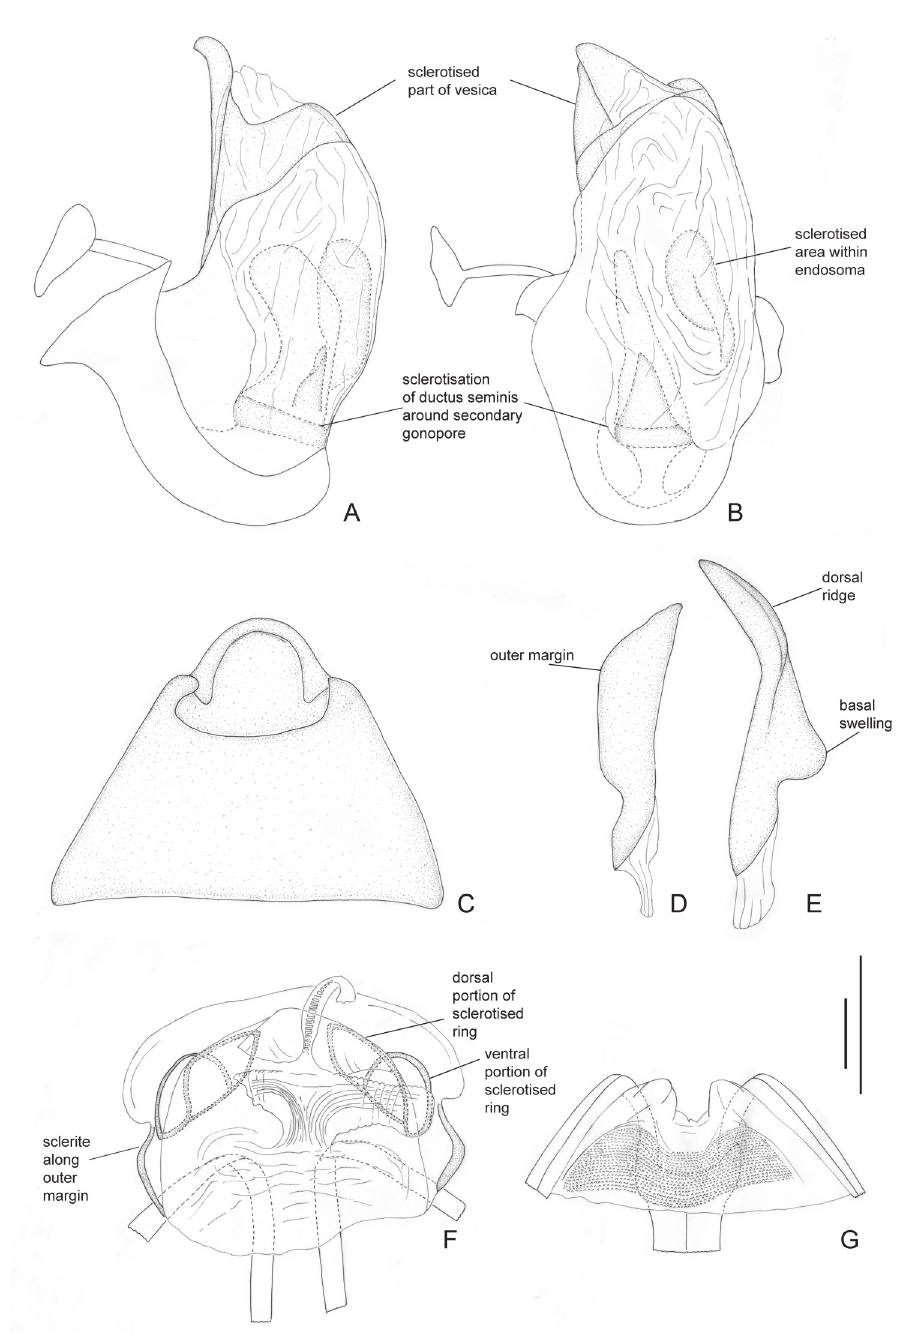
Fig. 7. Genitalia of C. malcolmae Slater & Gross, 1977. A . Aedeagus, left lateral view. B . Aedeagus, ventral view. C . Genital capsule. D . Right paramere. E . Left paramere. F . Dorsal labiate plate of bursa copulatrix. G . Posterior wall of bursa copulatrix. Scale bars = 0.1 mm (the large scale bar is for A–B and D–E, the small scale bar is for C and